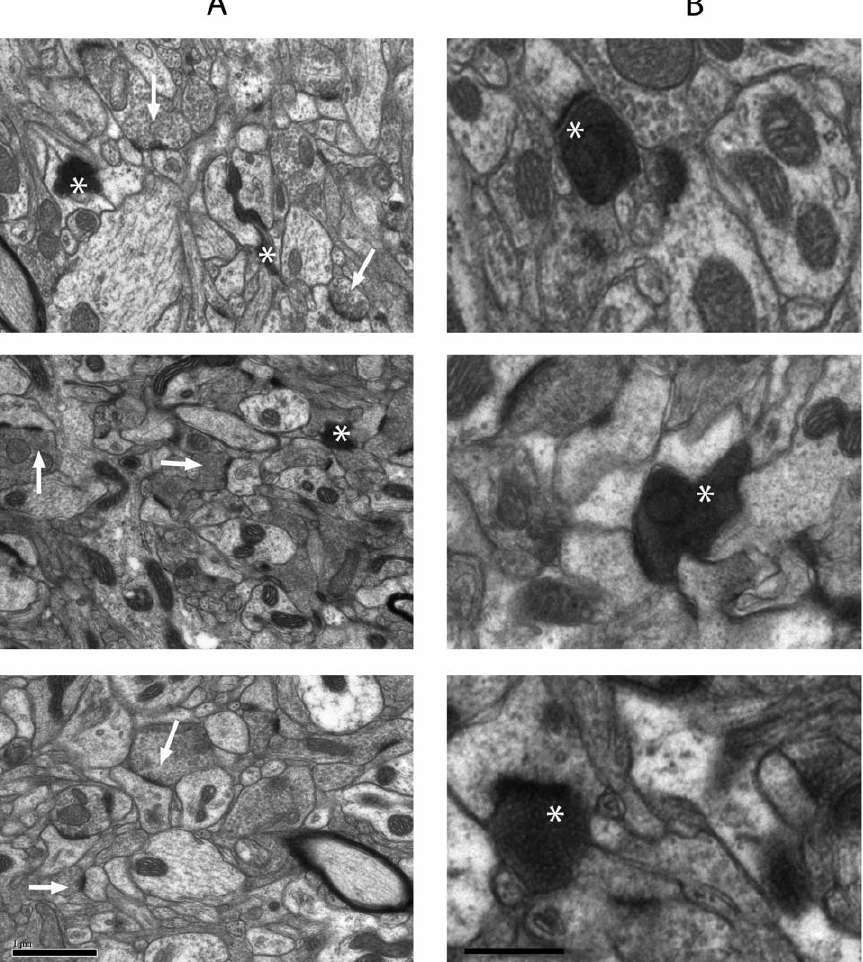
Figure 2. Widespread synaptic degeneration in the striatum of young (2 month old) wild-type, but not heterozygous Wld S or homozygous Wld S mice, 3 days after cortical lesion. Representative electron micrographs of striatal synapses at low power (A) and higher power (B) from a young wild-type mouse (top panel), heterozygous Wld S mouse (middle panel) and homozygous Wld S mouse (bottom panel). Asterisks indicate degenerating synaptic profiles (identified principally by their electron dense cytoplasm) and arrows indicate healthy (i.e. non- degenerating) synaptic profiles. Degenerating synapses were readily identified in wild-type mice, occasionally observed in heterozygous Wld S mice and rarely observed in homozygous Wld S mice. However, the morphological appearance of degenerating synapses was indistinguishable between the different genotypes, suggesting that synapses in mice expressing the Wld S gene ultimately degenerate by the same mechanism as in wild-type mice, albeit after a delay. Scale bars; A=1 m m, B=0.5 m